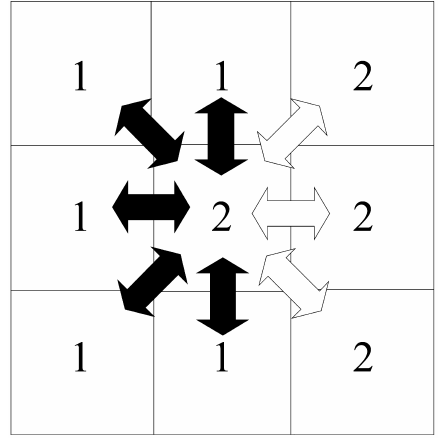
Figure 2. Calculation of the free energy of an element of the matrix (Q i = 2). In this example, G i = 5 (five different